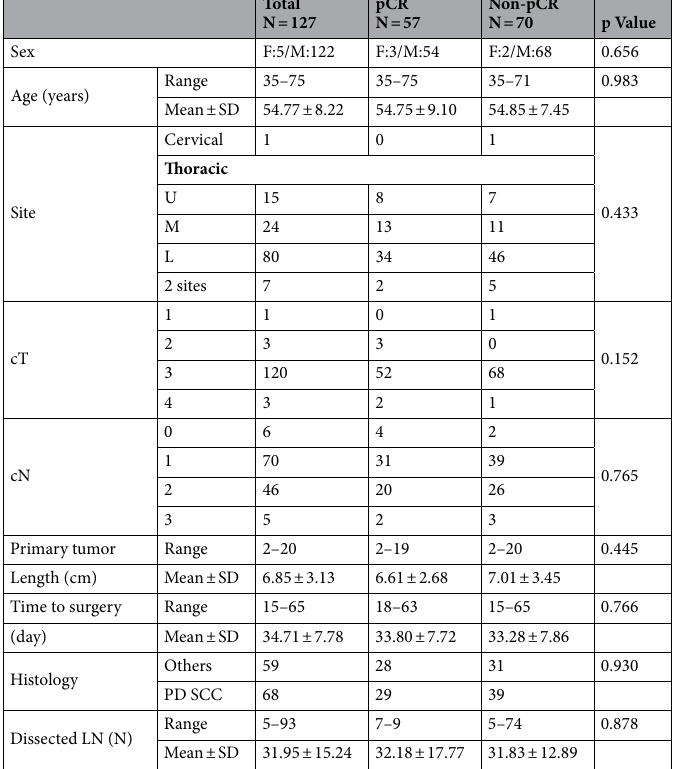
Table 1. Patients’ characteristics. pCR pathological complete response, N number, F female, M male, SD standard deviation, U upper thoracic, M middle thoracic, L lower thoracic, cT clinical T classification,